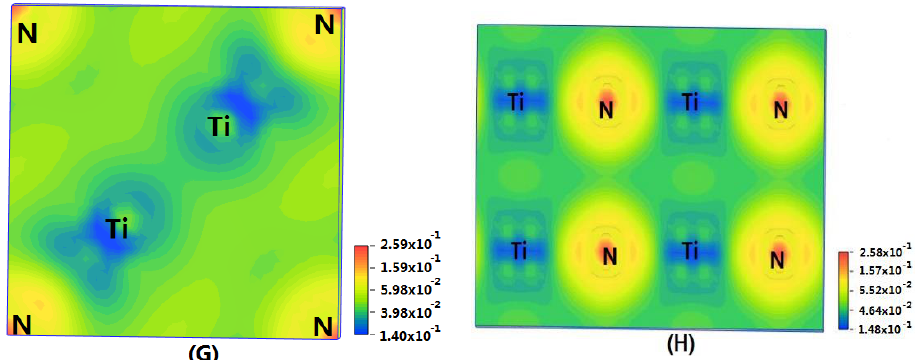
一 m; ( B ) ZrN with space 一 3d; ( F ) Zr 3 N 4